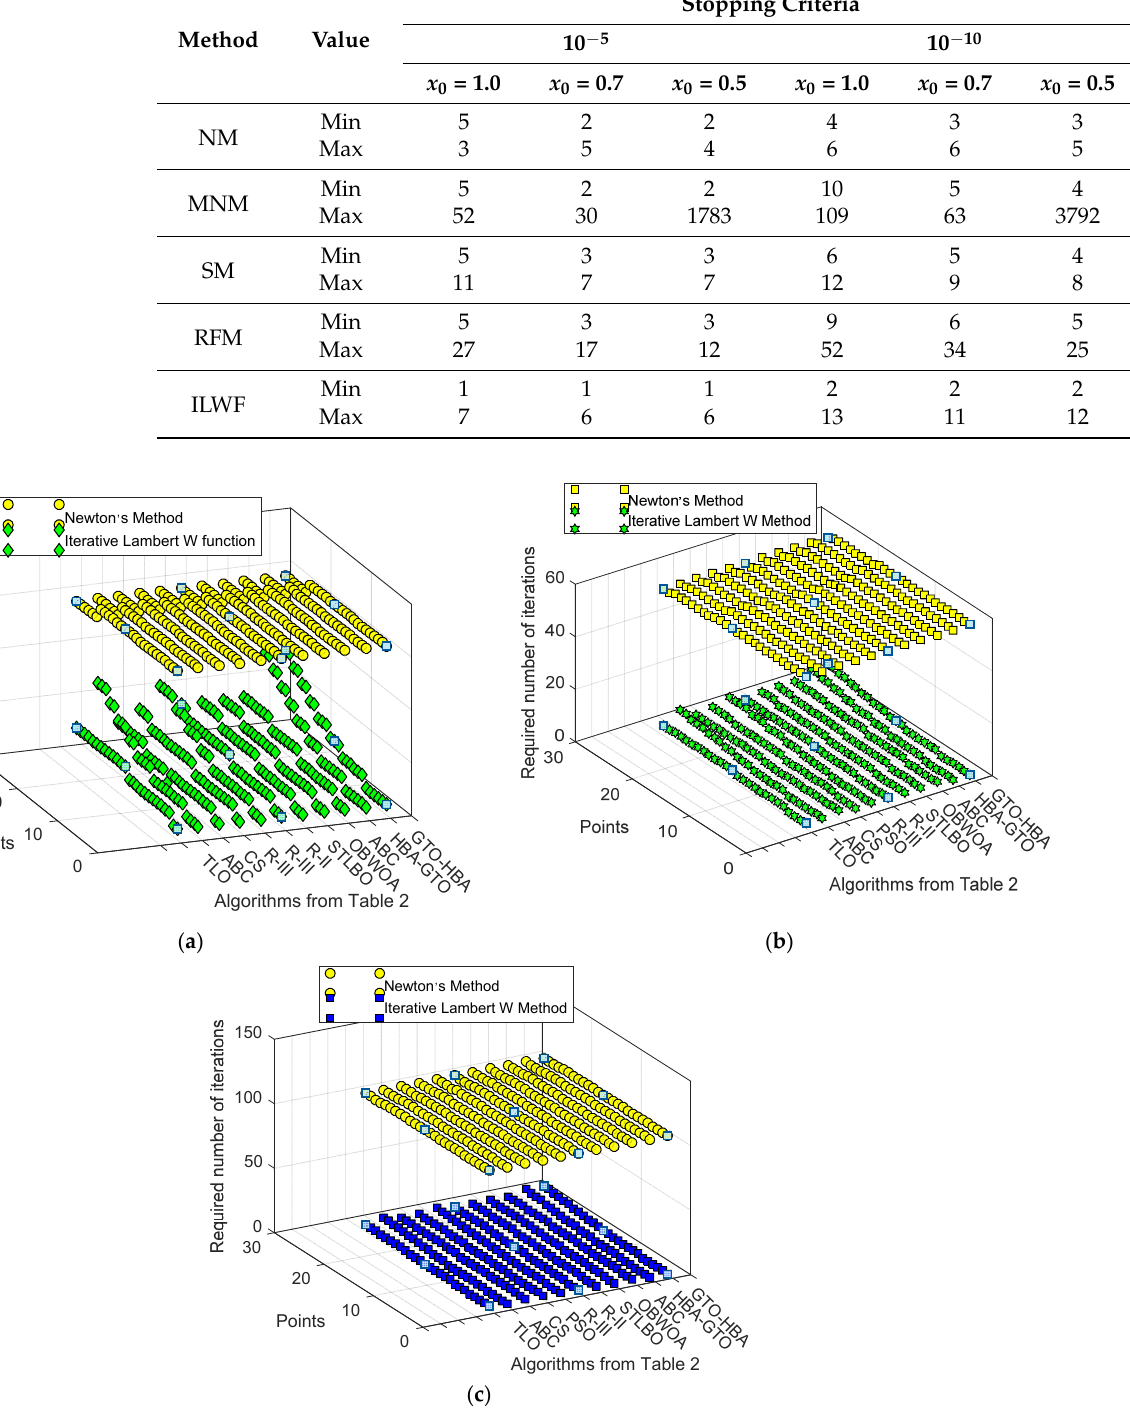
Figure 18. Required number of iterations for all voltage values with 10 − 5 stopping criterion using Newton’s and iterative Lambert W methods: ( a ) x 0 = 10; ( b ) x 0 = 50; ( c ) x 0 = 100.